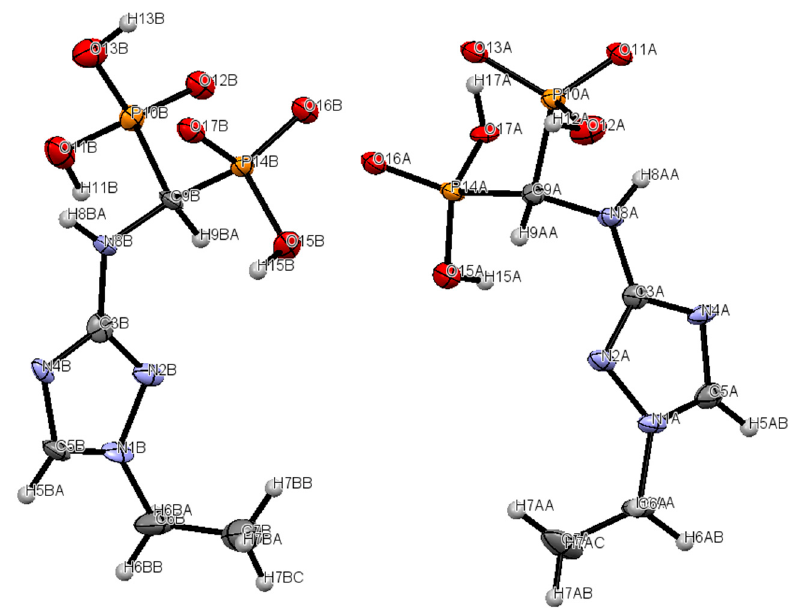
Figure 2. Compound 2 in the asymmetric part of unit cell. Thermal ellipsoids are shown at the 50% probability level.